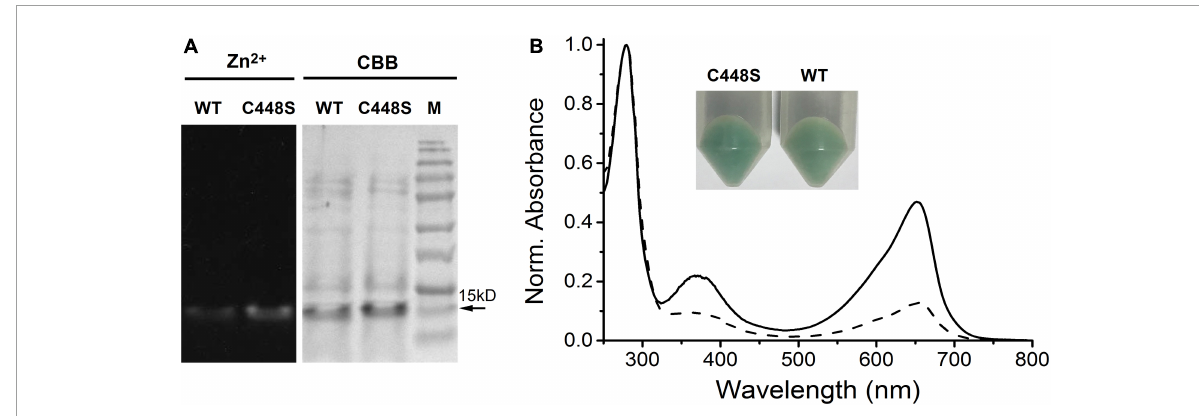
FIGURE1 Chromophorylation of SPI1085g3 and C448S with BV. (A) SDS–PAGE analyses of SPI1085g3 and C448S chromophorylated with BV: zinc-induced fluorescence (Zn 2 + , left) and Coomassie brilliant blue (CBB, right) staining. The marker (SMOBiO, PM2510) indicates protein molecular weights of 180, 140, 100, 75, 60, 45, 35, 25, 15, and 10 kDa from top to bottom. (B) Absorbance spectra of BV-incorporated SPI1085g3 (dashed line) and C448S (solid line). Protein absorbance values at 280 nm were adjusted to be equal. The color of E. coli cell